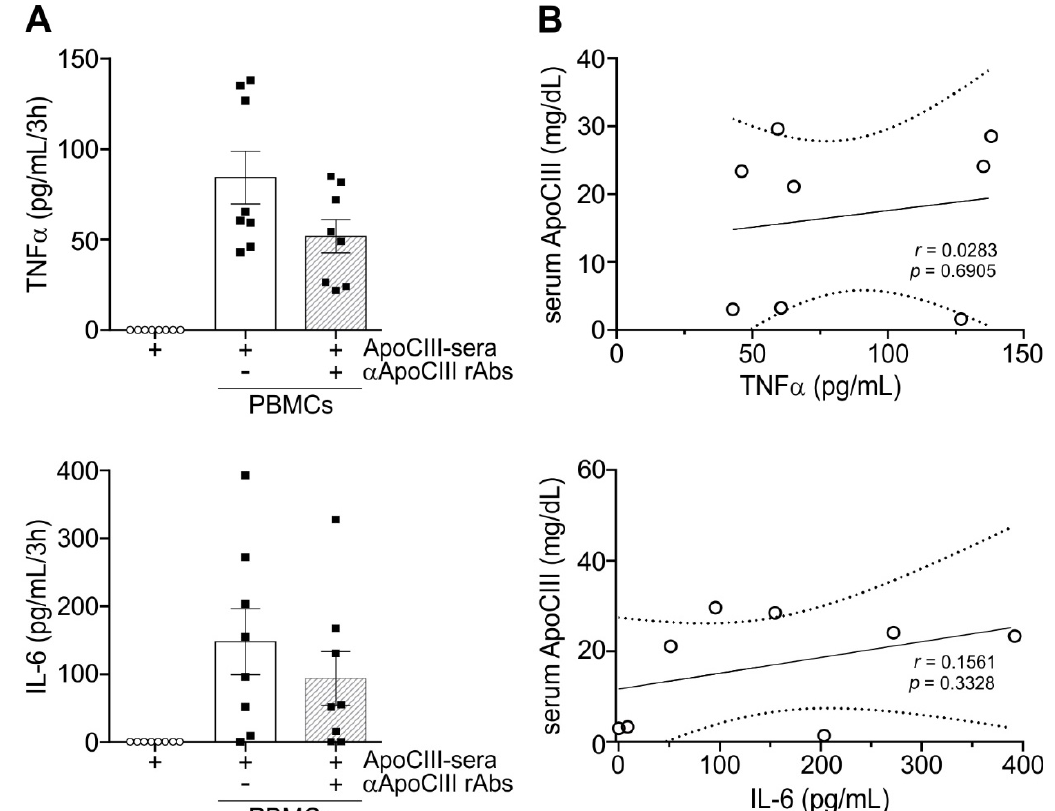
Figure 5. Effect of sera with measured concentrations of ApoCIII on TNF α and IL-6 release by PBMCs. Panel A : PBMCs isolated from buffy coats as reported in Section 4 were cultured for 3 h with the addition of ApoCIII-sera in the presence or absence of 60 µg/mL ApoCIII-neutralizing rAbs. After treatment, sera with known concentrations of ApoCIII (ApoCIII-sera) and PBMC-derived supernatants were collected and analyzed for TNF α and IL-6 content by ELISA. Data are expressed as mean± SEM (n=8) and were analyzed by the Kruskal–Wallis test followed by Dunn’s multiple comparison test.. Panel B displays two scatter plots showing the correlation between TNF α or IL-6 release by PBMCs and the ApoCIII concentrations of the sera that were used as stimuli. The r-value determined by Pearson correlation is displayed together with the p -value.